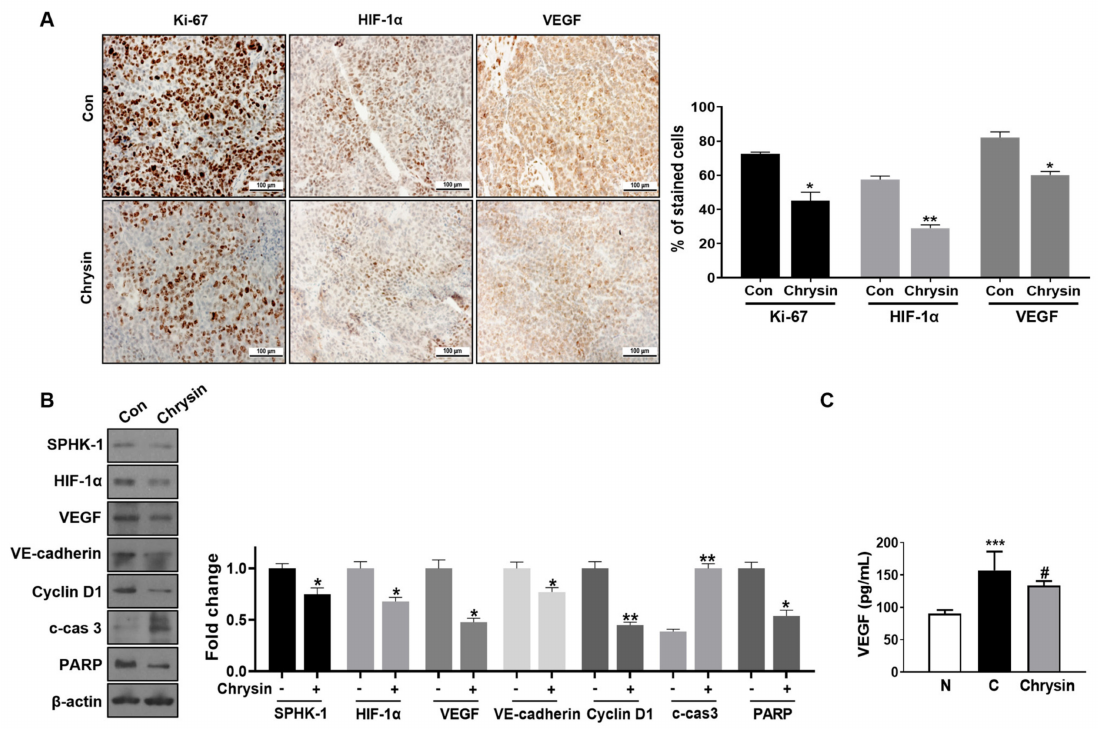
Figure 6. Anti-cancer effects of chrysin in the proposed mouse xenograft mouse model. ( A ) Repre- sentative specimen of immunohistochemical staining for Ki-67, HIF-1 α , and VEGF and bar graph expressing the Ki-67, HIF-1 α , and VEGF percentage of stained cells (%) in tumor sections. Data represent mean ± SD; n = 6/group. * p < 0.05, and ** p < 0.01 (compared to control group). ( B ) Western blotting for SPHK-1, HIF-1 α , VEGF, VE-cadherin, Cyclin D1, c-cas3, PARP, and β -actin of selected tumors. Bar graphs represent the quantification of interest protein related to β -actin, presented as a fold change of control. * p < 0.05 and ** p < 0.01 when compared to untreated control. ( C ) The concentration of VEGF in the serum samples of nude mice determined by ELISA. Data represent mean ± SD; n = 6/group. *** p < 0.001 (compared to normal control (N)), and # p < 0.05 (compared to control